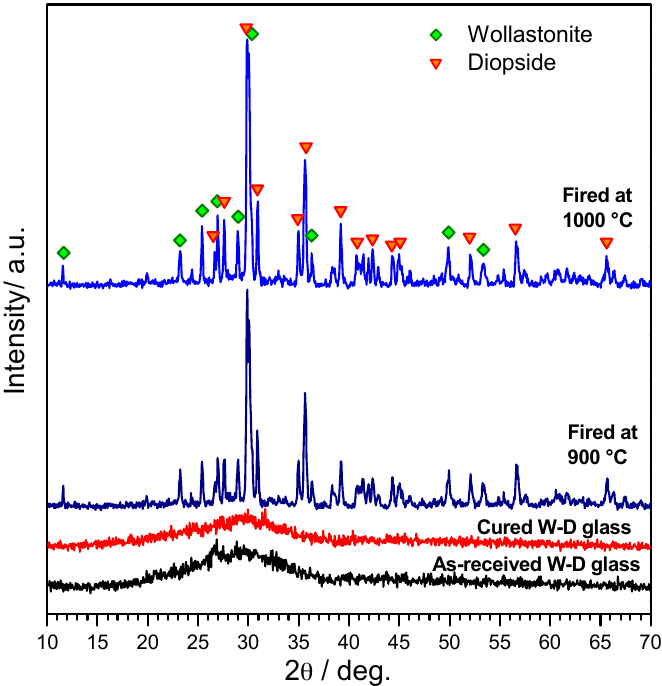
Figure 6. XRD patterns of W-D glass, cured W-D glass after demolding and W-D glass-ceramic foam after firing (heating rate: 5 °C/min).